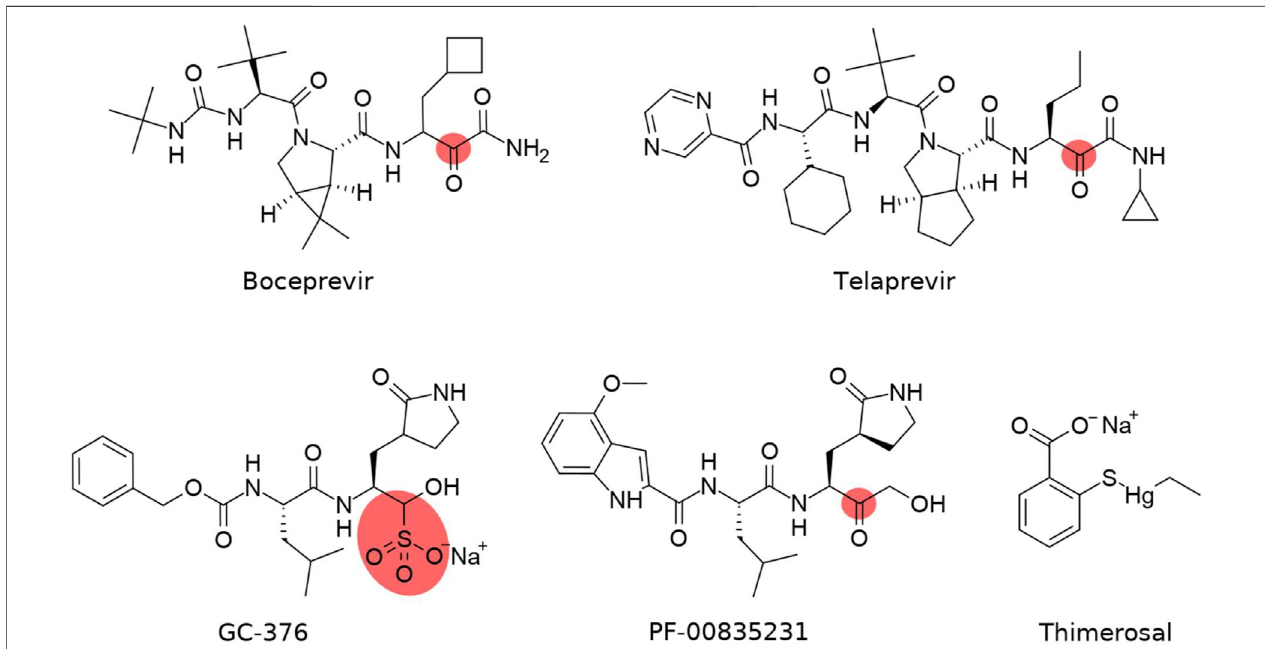
FIGURE 2 | Structures of covalent inhibitors of SARS-CoV-2 M pro . The covalent-binding atom is highlighted. The sulphonate group in GC-376 is cleaved upon Cys145 binding.